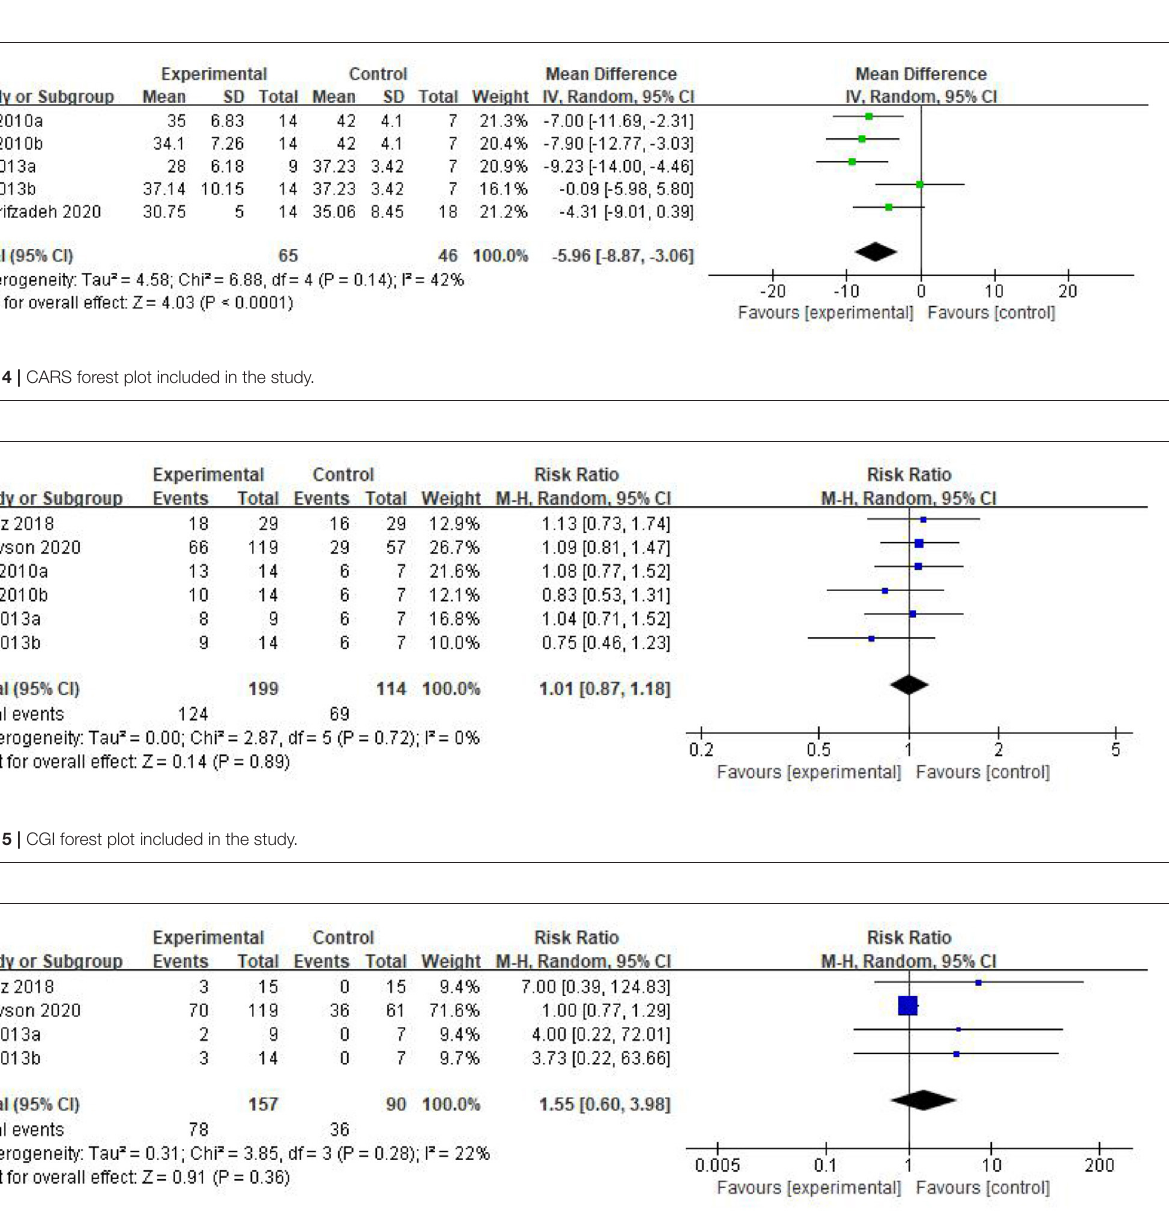
FIGURE 6 | Forest plot of adverse